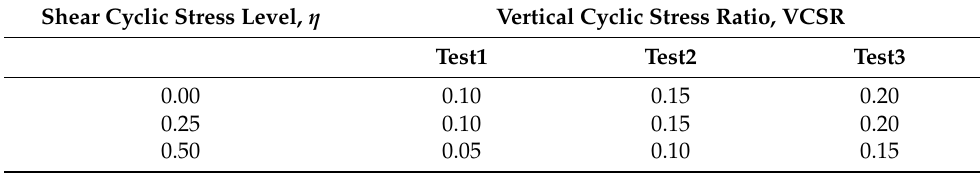
Table 3. Scheme of cyclic